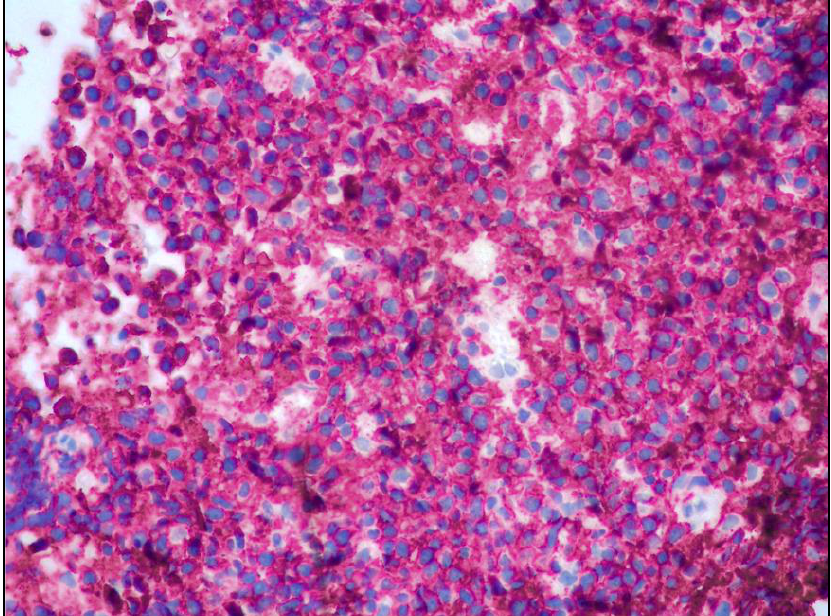
Figure 3. CD20 positivity highlighting the B-cell origin of the lymphoid proliferation (CD20 im- munostaining; 200× magnification; original image from Prof. S.A.).